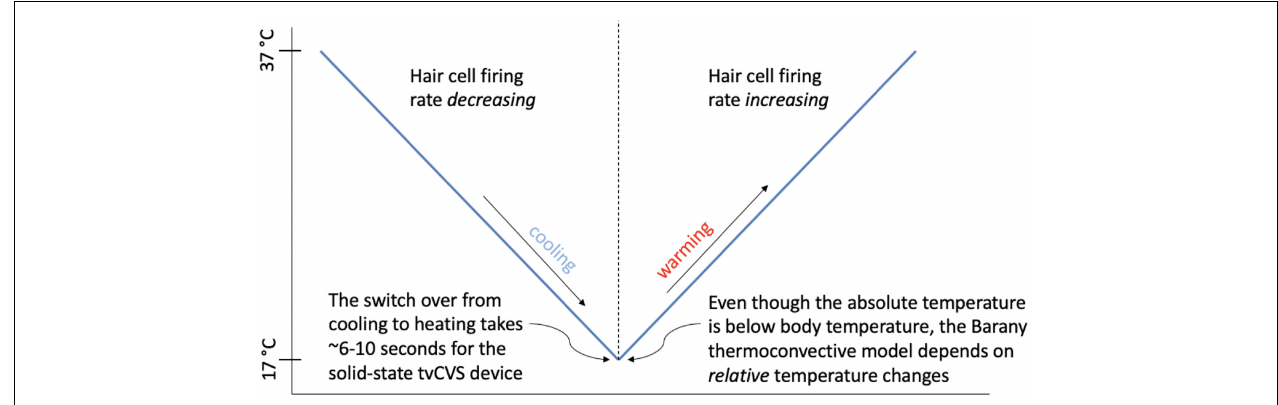
FIGURE 11 | Depiction of the transition between hair cell firing rate states as a function of the direction of the temperature